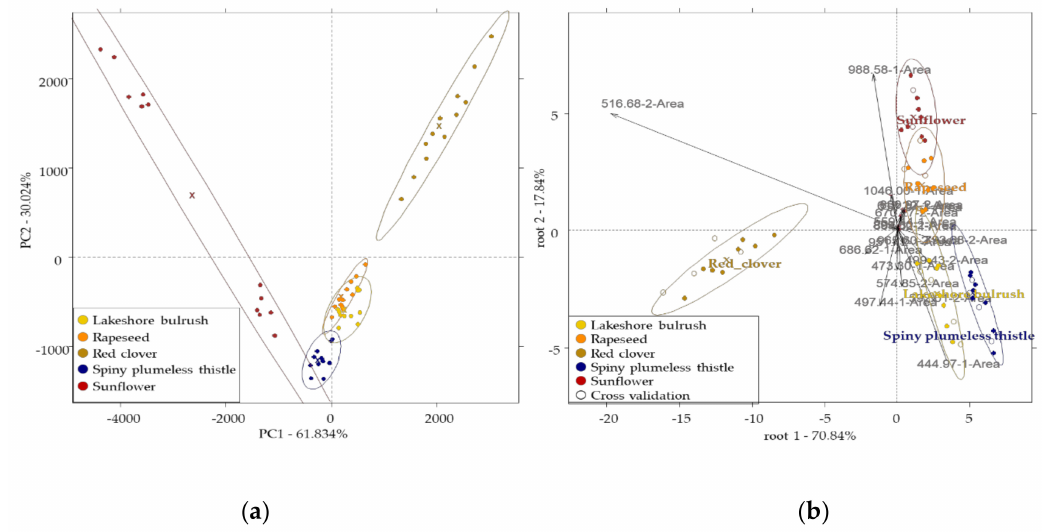
Figure 3. Results of the electronic nose using all the methods ( n = 60): ( a ) PCA score plot; ( b ) LDA score plots built for the classification of botanical groups with 95% confidence interval ellipses. x denotes the center of the ellipses, on figure ( b ) solid point are for the training set, and hollow points are for the validation